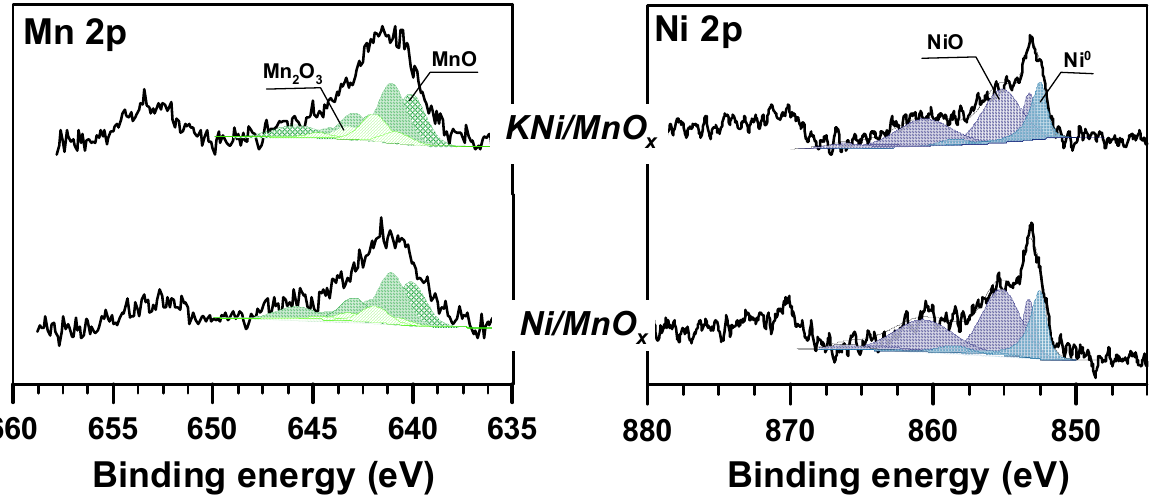
Figure 11. High-resolution XPS spectra of Mn 2p and Ni 2p regions collected from the surface of Ni/MnO x and KNi/MnO x catalysts after 18 h of SRE reaction at 420 °C (H 2 O/EtOH molar ratio = 12/1).